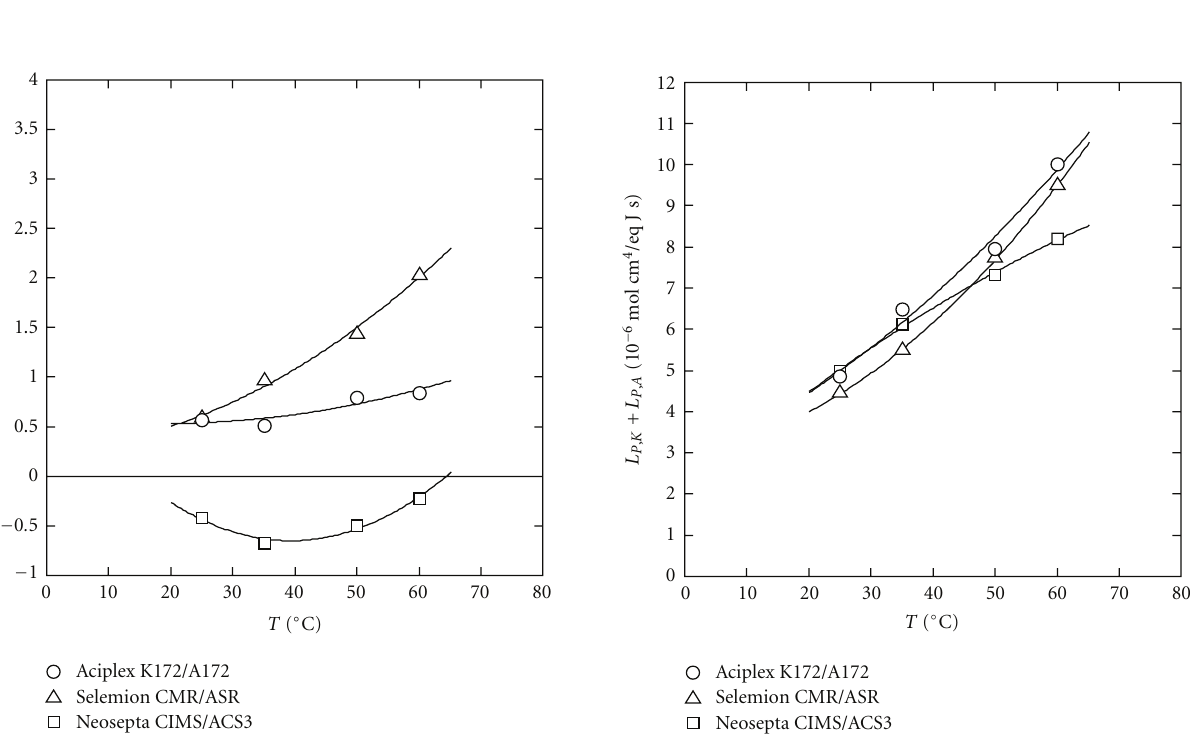
Figure 8: Relationship between temperature and hydraulic perme-